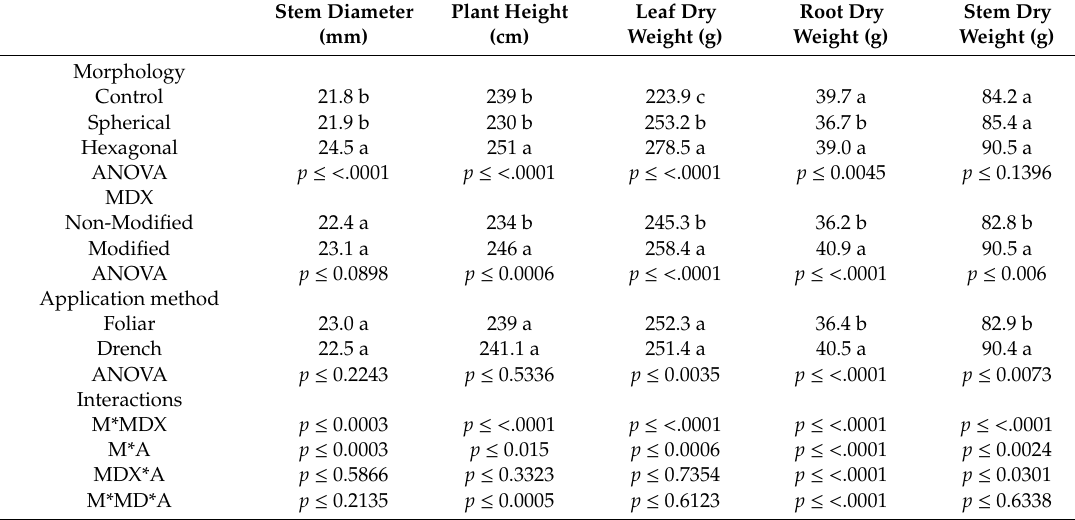
Table 1. E ff ect of di ff erent morphology, modification or non-modification with maltodextrine, and Table 1. Effect of different morphology, modification or non-modification with maltodextrine, and application methods of ZnO-NPs on di ff erent growth parameters of tomato application methods of ZnO-NPs on different growth parameters of tomato plants.